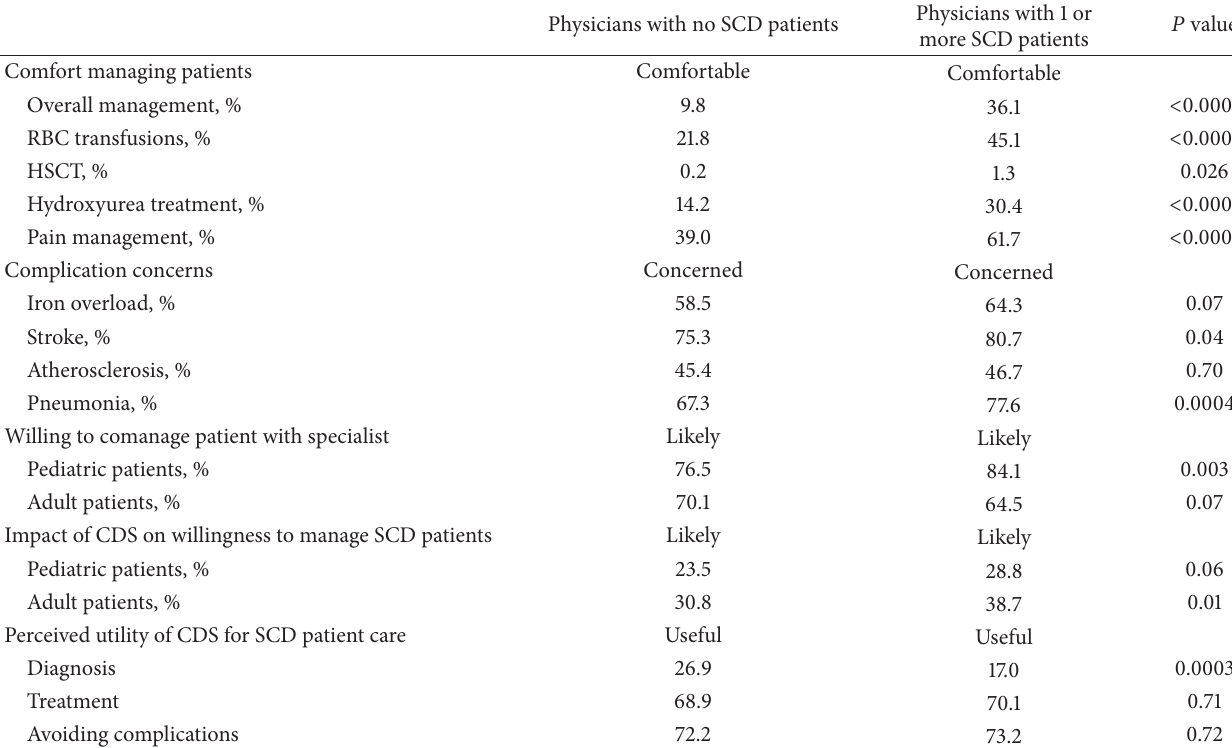
Table 4: Physician perceptions of SCD by number of patients with